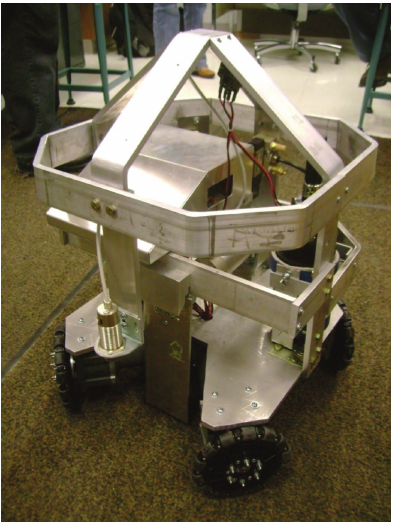
Figure 9: The final built